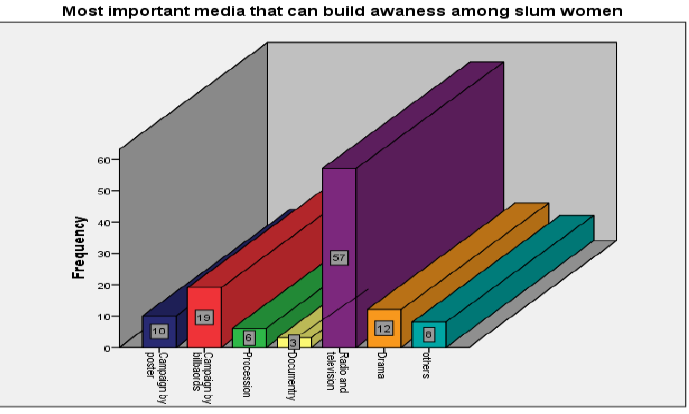
Figure 4: Building awareness among slum